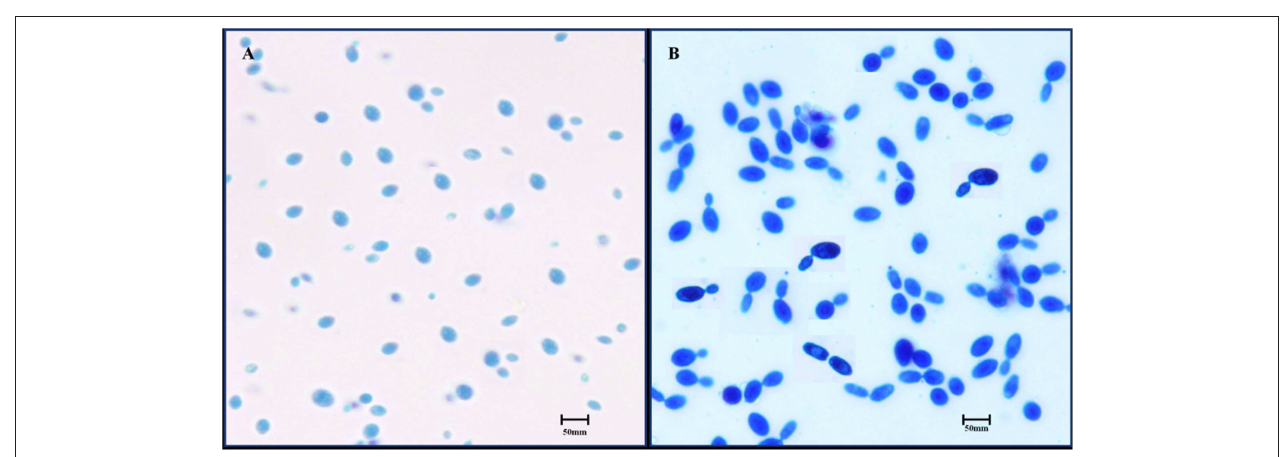
FIGURE 1 | Microscopic observation of S. boulardii cells. (A) Oval and/or spherical shapes under low power objective. (B) Budding of S. boulardii under high power objective.